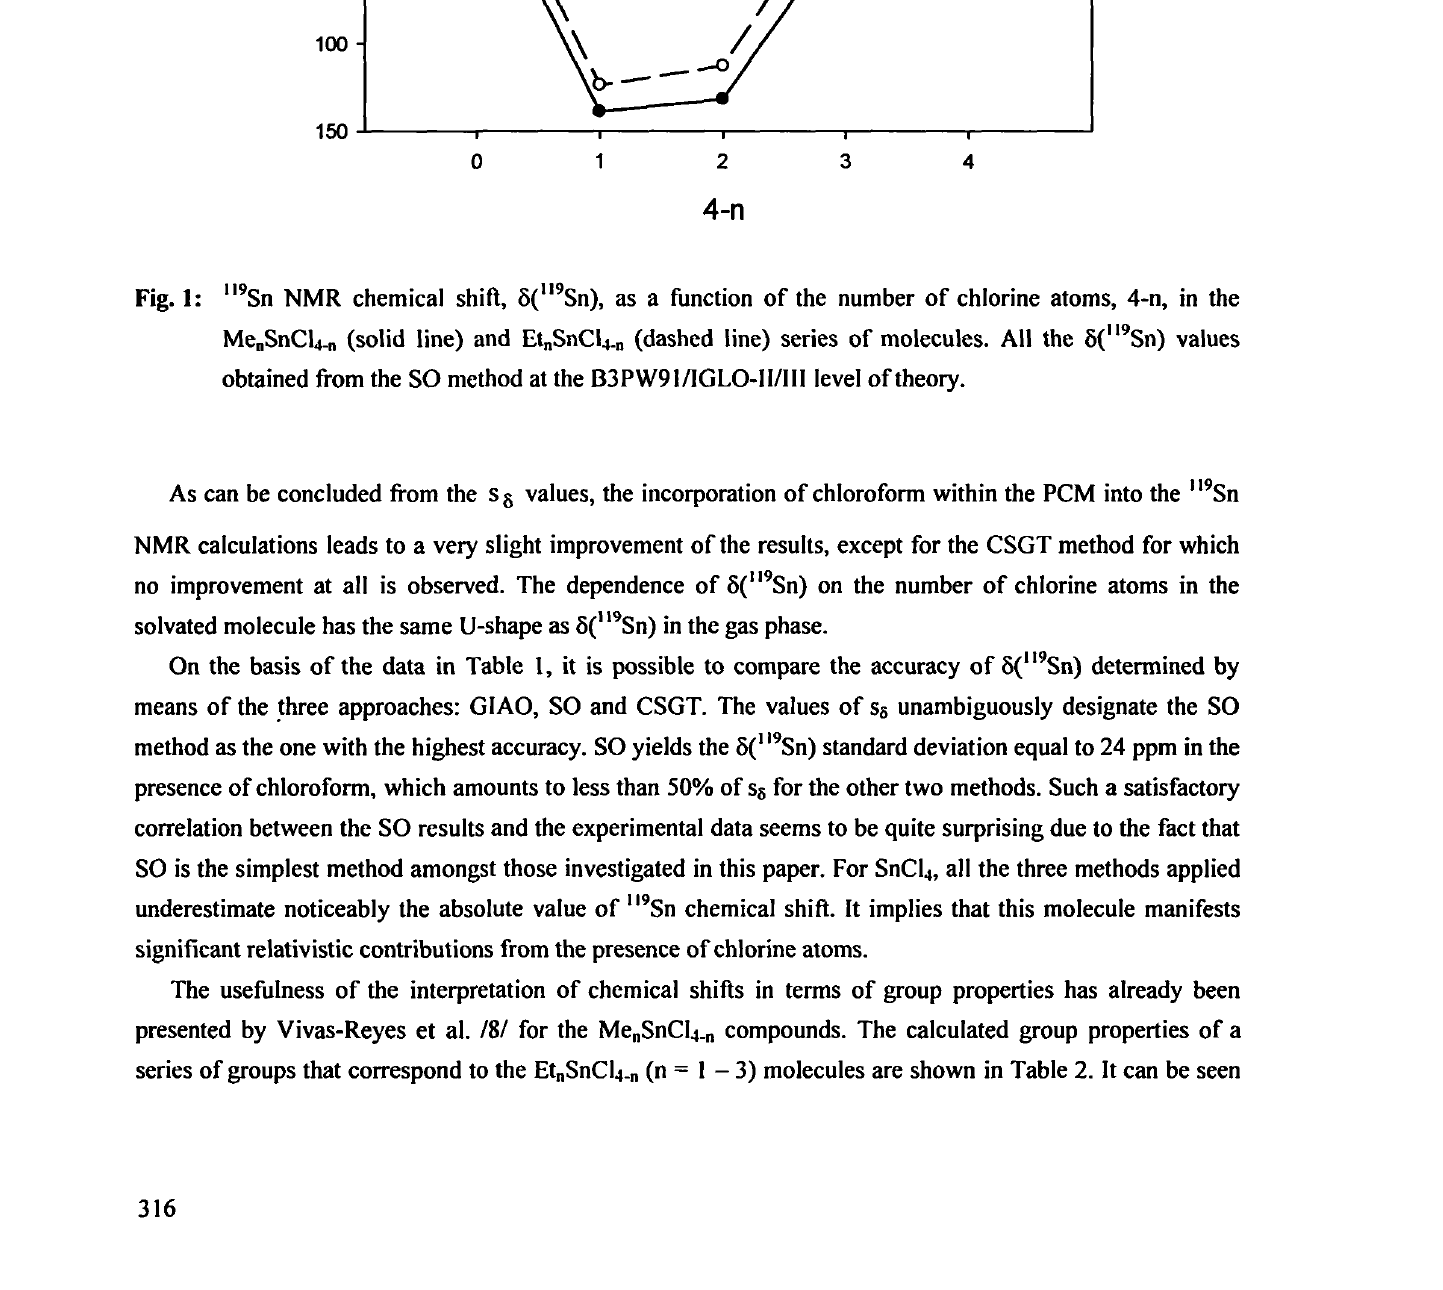
Fig. 1: " 9 Sn NMR chemical shift, 5(" 9 Sn), as a function of the number of chlorine atoms, 4-n, in the Me„SnCl _ (solid line) and Et 4 n